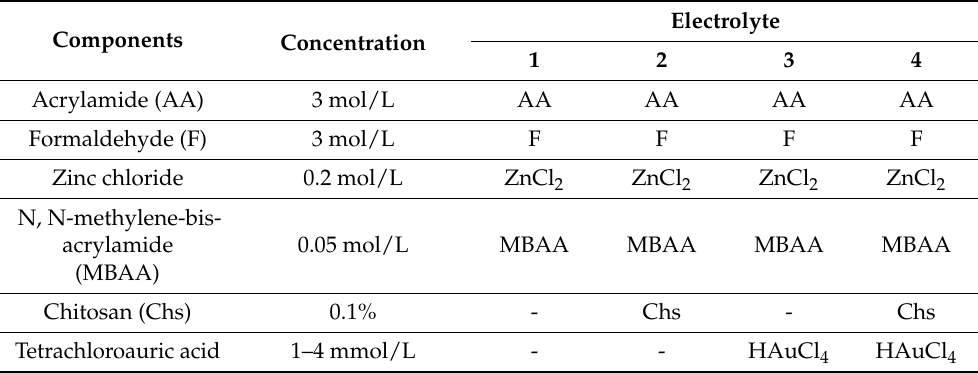
Table 1. Electrolyte compositions for electropolymerization. Components Concentration